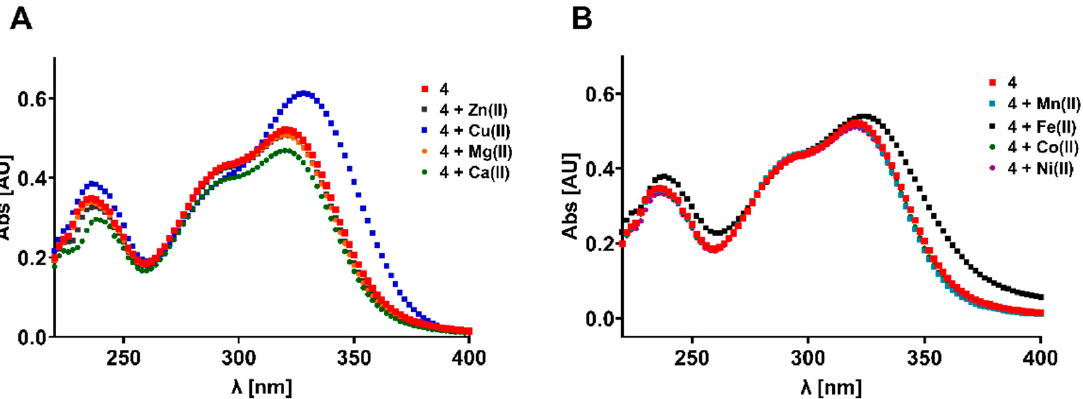
Figure 4. Metal chelation properties of N -propargyhydroxamate 4 . Absorption spectra changes for compound 4 incubated with different metal ions (panel ( A ): Zn 2+ , Cu 2+ , Mg 2+ , Ca 2+ ; panel ( B ): Mn 2+ , Fe 2+ , Co 2+ , Ni 2+ ) at equimolar concentrations.